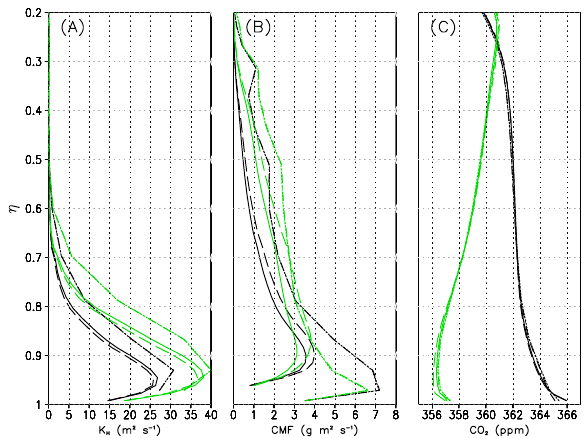
Fig. 2. Vertical profiles of (A) turbulent diffusion, (B) cumulus mass flux and (C) CO 2 mixing ratio, zonally averaged, binned into mid- latitudes (30–70 ◦ N) and plotted as a function of the hybrid coordi- nate eta ( η) for each of the four meteorological analyses (line styles correspond to Fig. 1). Annual averages are plotted in black, sum- mer averages in green. Mass fluxes from GEOS-4 are identical and therefore lie directly over one another. Note that vertical diffusion is zero in GEOS-4 at the lowest model level and cumulus mass flux is zero in GEOS-5 at the two lowest model